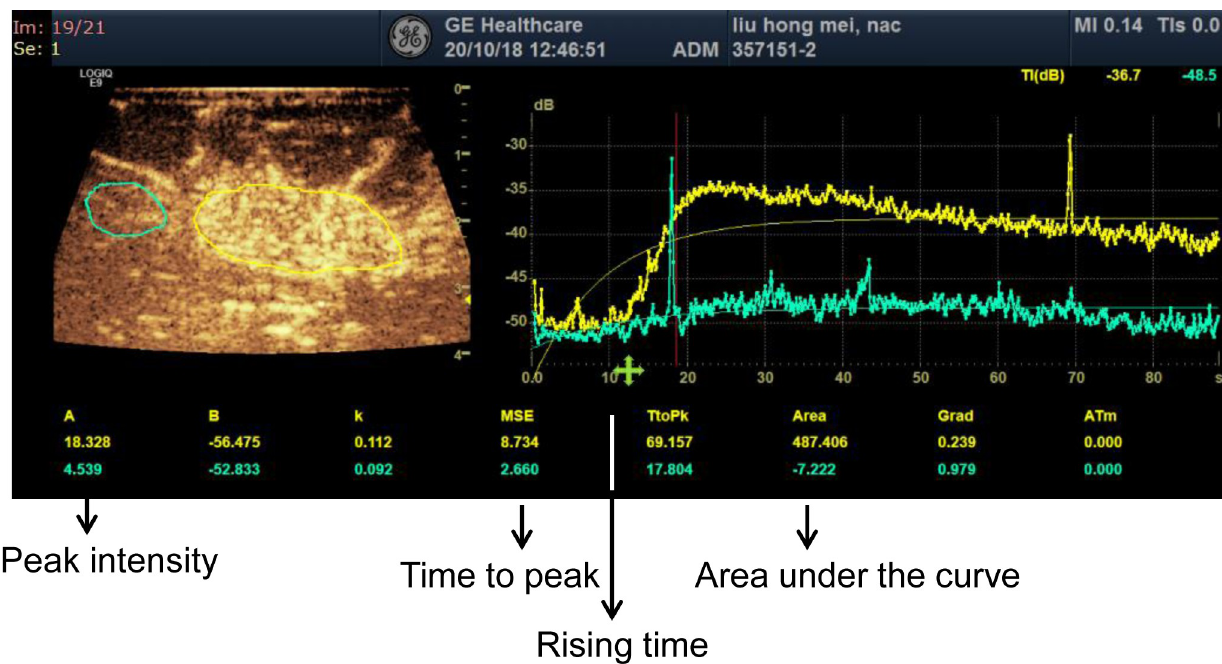
Fig 1. Time intensity curve analysis of contrast-enhanced ultrasound. The peak intensity, time to peak, rising time, and, the area under the curve were indicated in the figure.